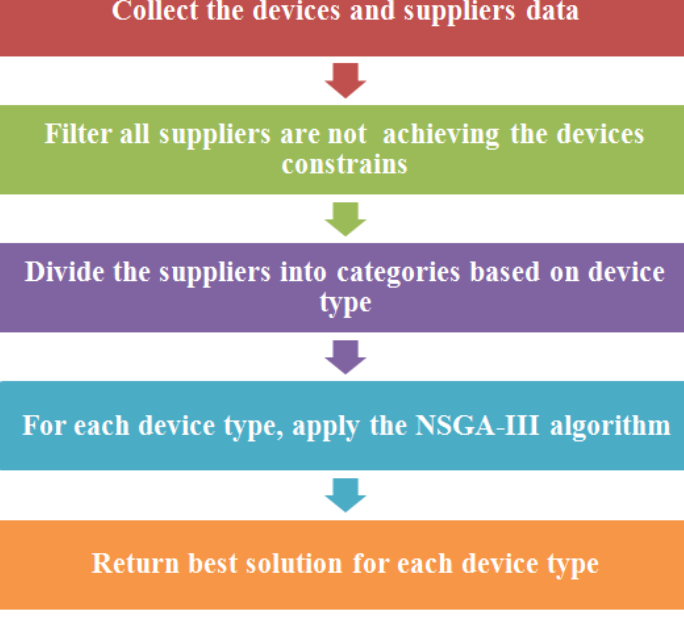
Figure 1. The proposed LSSM’s